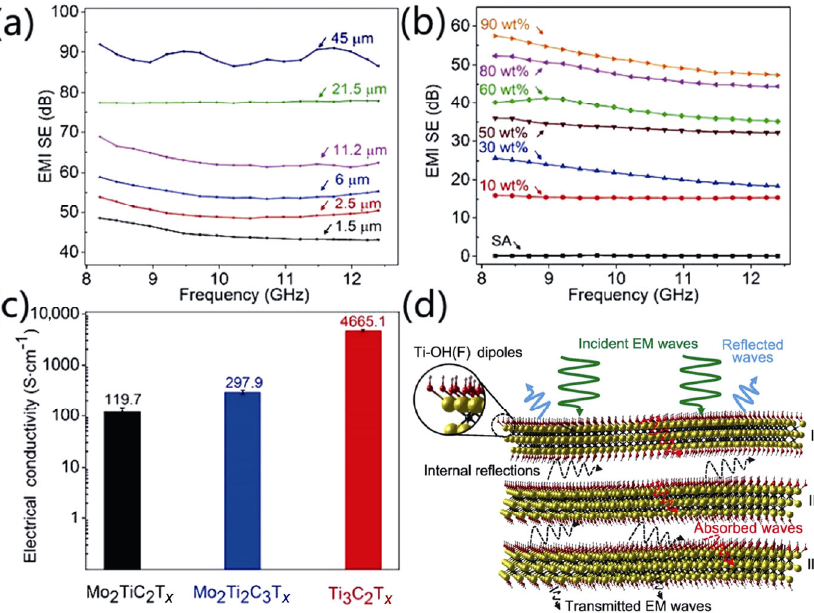
Fig. 26 (a) EMI SE of Ti 3 C 2 T x films. (b) EMI SE of Ti 3 C 2 T x –SA composites at thicknesses of 8–9 μ m. (c) Electrical conductivity of Mo 2 TiC 2 T x , Mo 2 Ti 2 C 3 T x , and Ti 3 C 2 T x . (d) Proposed EMI shielding mechanism for MXenes. Reproduced with permission from Ref. [240], © American Association for the Advancement of Science